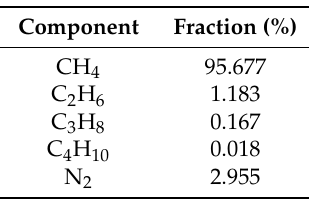
Figure 1. Scheme of Cooper–Bessemer GMVH-12 engine [21]. Table 1. Fuel gas composition.